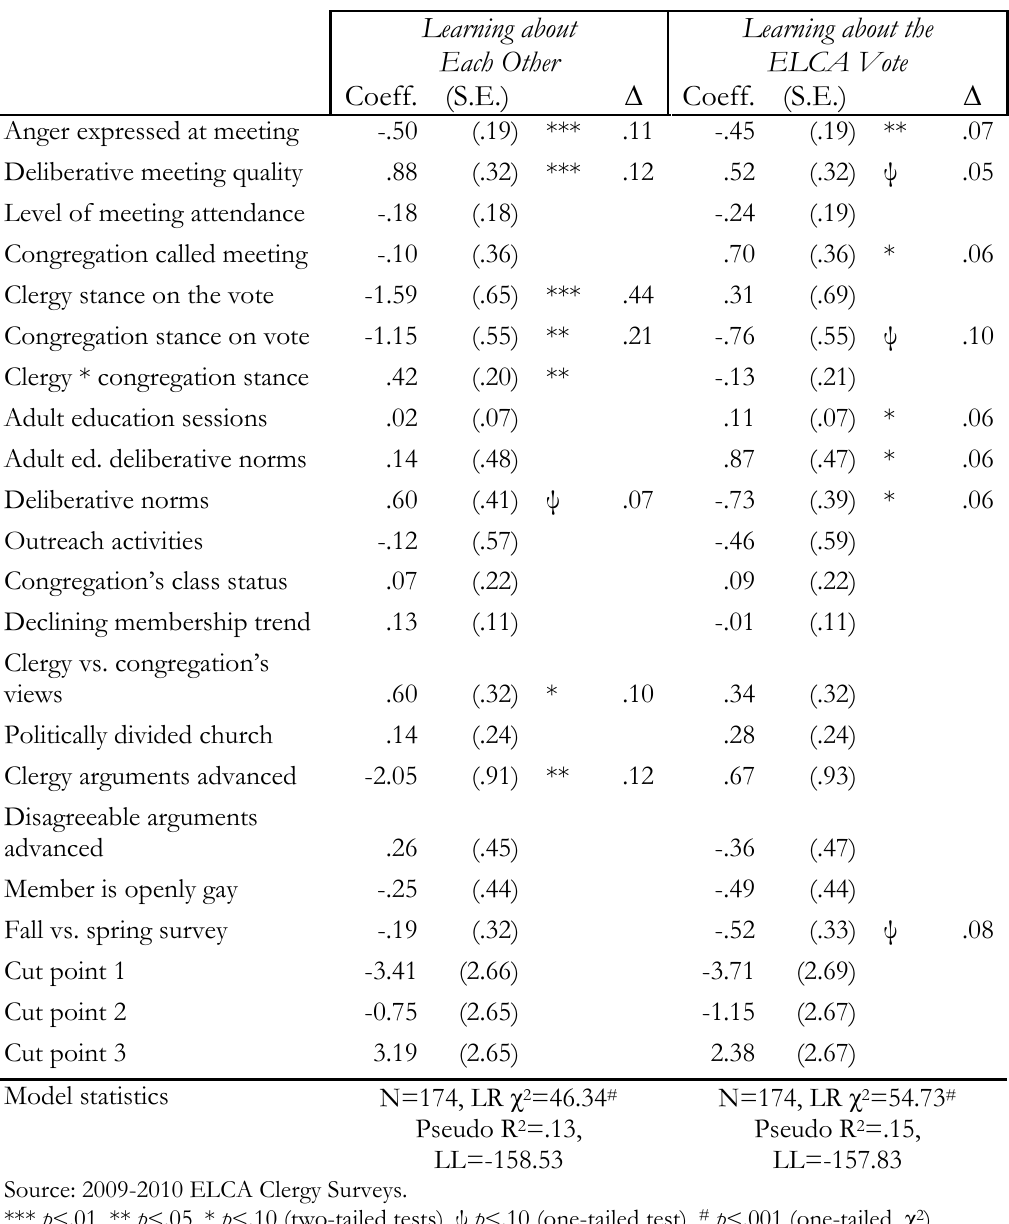
Table 3 : Whether the Meeting Helped Attendees Learn More about Each Other and the ELCA